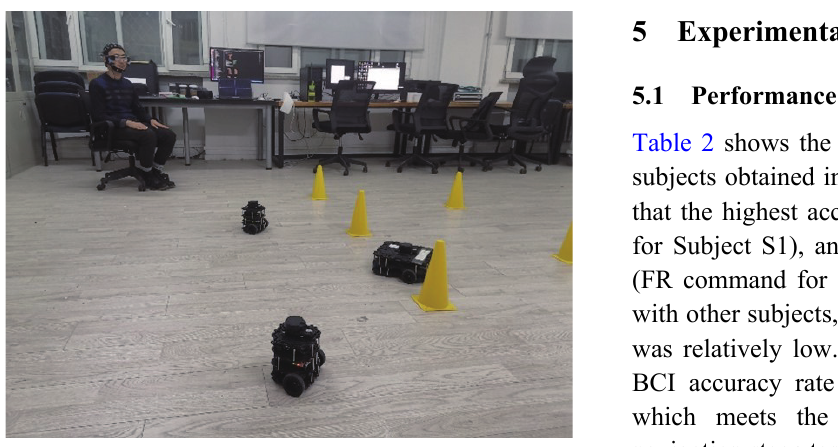
Fig. 6 Brain-controlled online navigation scene.